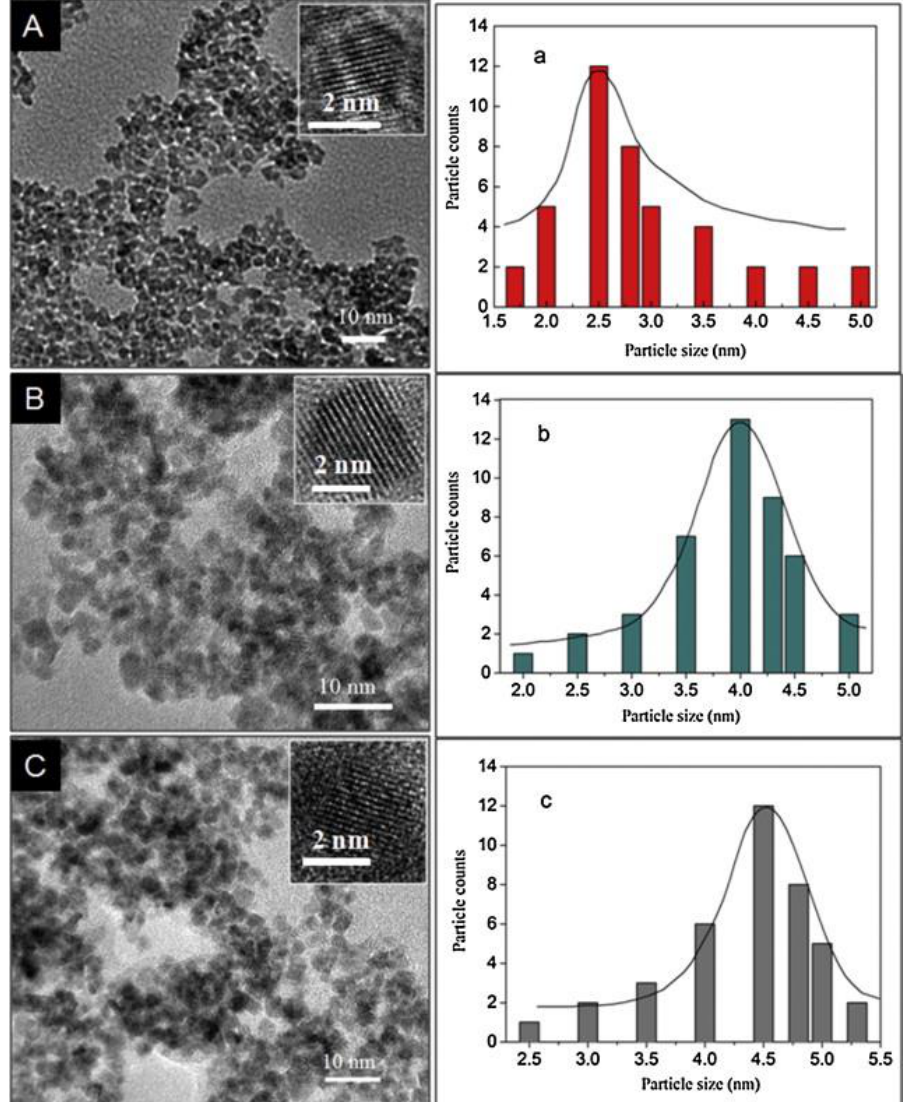
Figure 5. ( A – C ) TEM and HRTEM (insets) micrographs, and ( a – c ) relevant size distributions of SnO